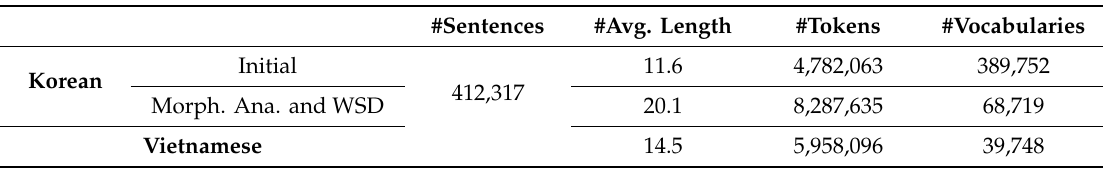
Table 11. The detail of the Korean-Vietnamese parallel corpus.